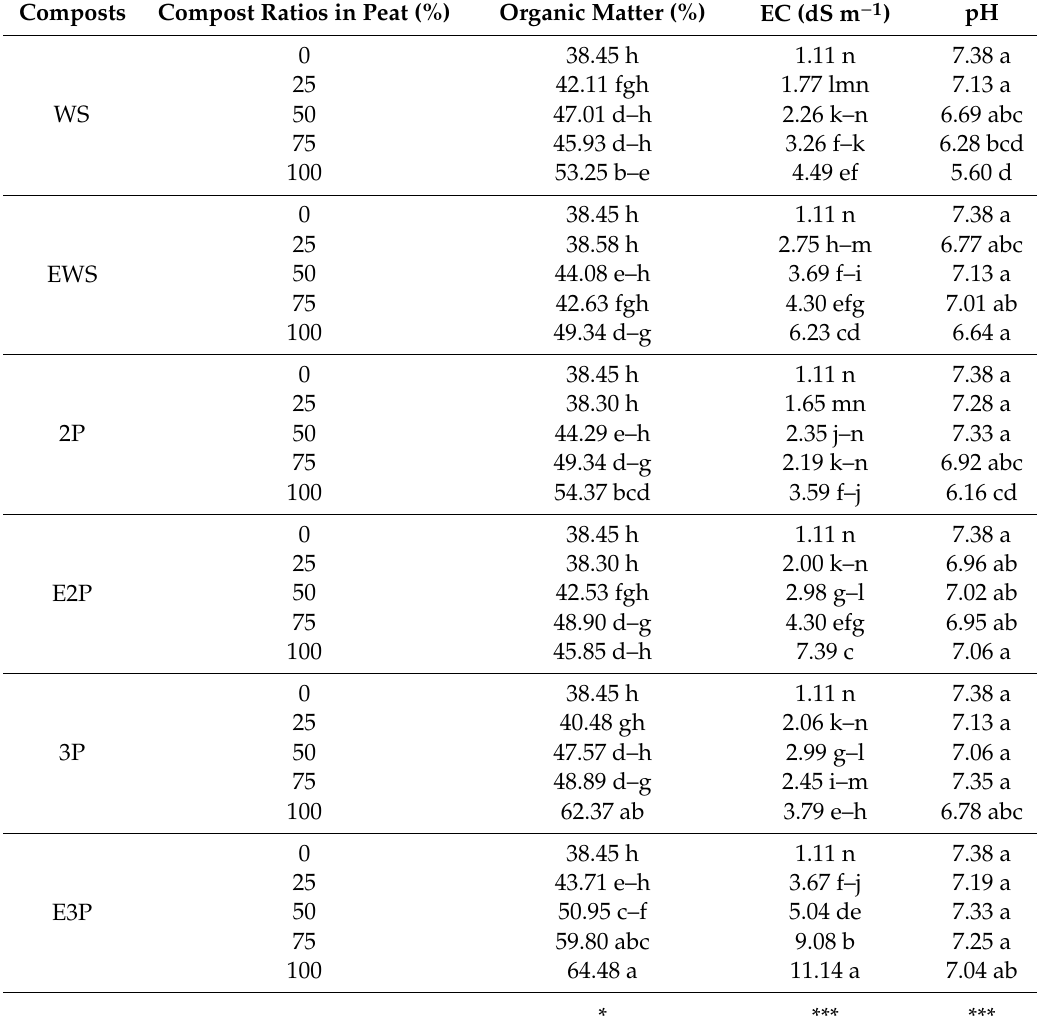
Table 2. Initial organic matter, EC, and pH values of the growing